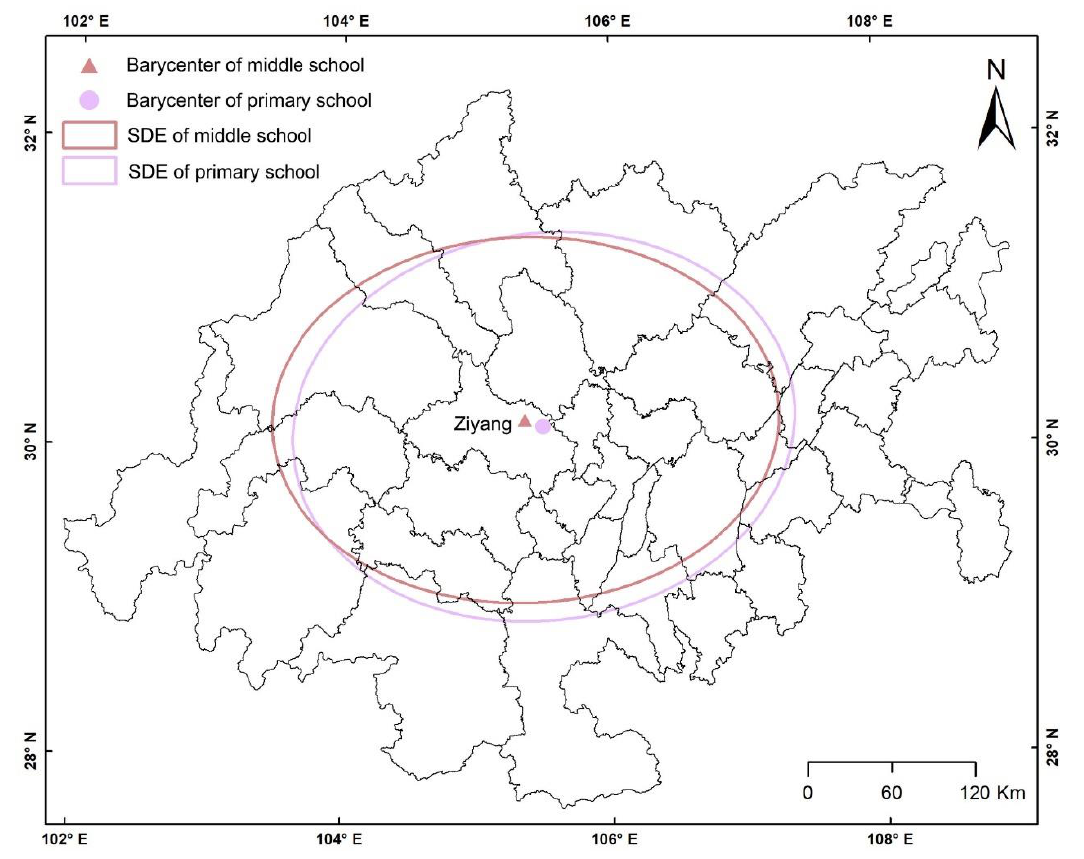
Figure 3. The SDE of PMSs.